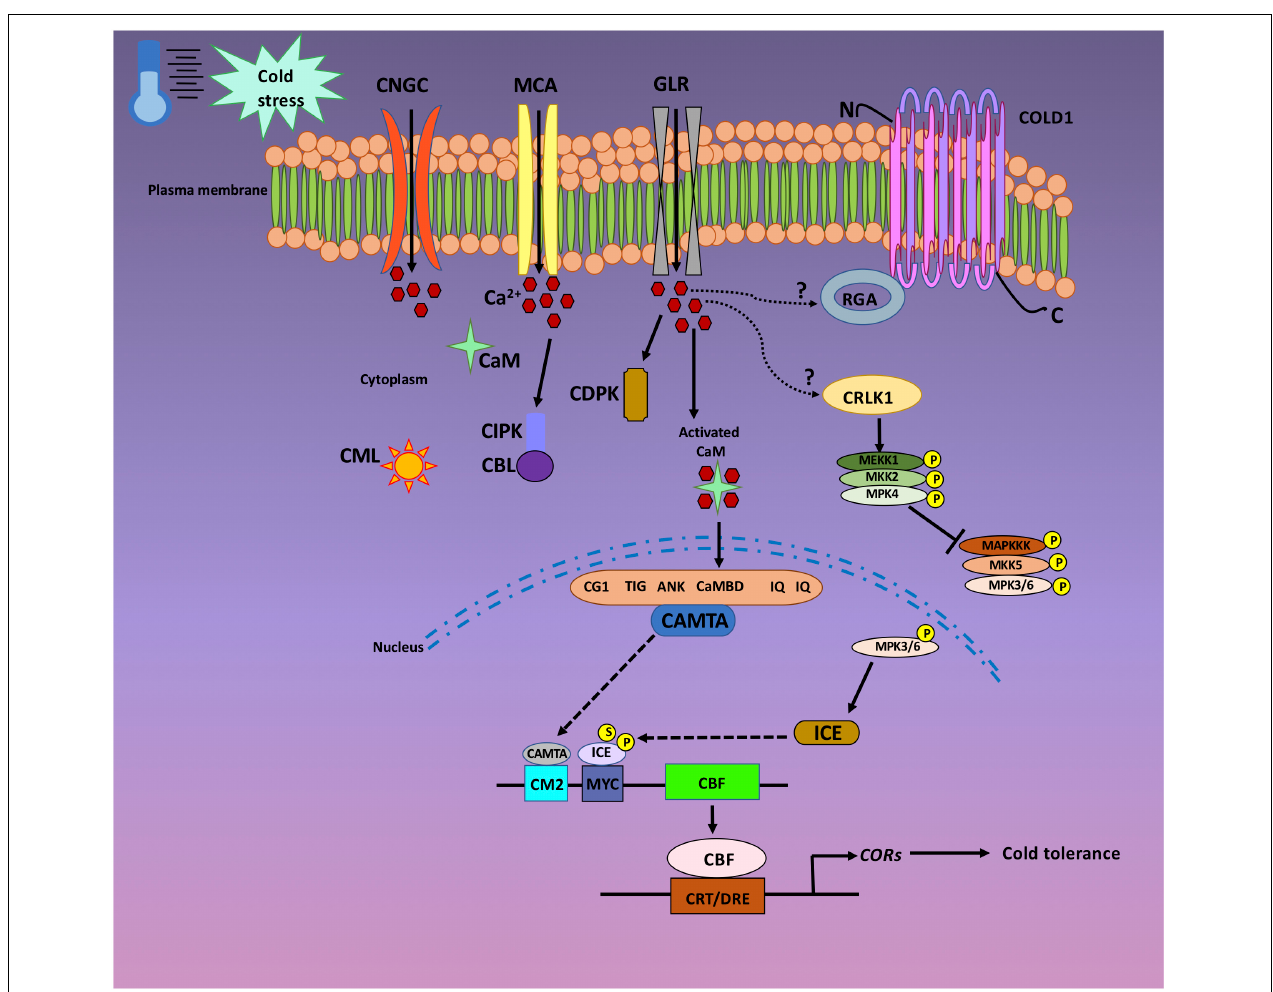
FIGURE 1 | Cold stress signaling in a plant cell. The plasma membrane is considered as one of the primary target for cold sensing and eventual transmission of Ca 2 + signals into the plant cell nuclei. Cyclic nucleotide-gated channels (CNGCs), glutamate receptor-like channels (GLRs), and the MID1-complementing activity (MCA) channels are the main plasma membrane Ca 2 + channels that allow the entry of Ca 2 + ions into the cytoplasm. Once the Ca 2 + ion enters the plant cell, they are sensed by Calmodulins (CaMs) and Calmodulin-like proteins (CMLs), Calcineurin B-like proteins (CBLs), and Ca 2 + -dependent protein kinases (CDPKs). Upon cold exposure, plasma membrane associated cold sensor chilling-tolerance divergence 1 (COLD1) interacts with G protein a subunit (RGA). Ca 2 + /CaM regulated receptor-like kinase (CRLK) positively regulate cold triggered gene expression by inducing the MEKK1–MKK2–MPK4 pathway. CRLK suppress cold-induced activation of MPK3/6 and is necessary for inducer of CBF expression (ICE) accumulation. ICE proteins are stabilized by either phosphorylation (P) or sumolyation (S). Calmodulin binding transcription activators (CAMTAs) activate C-repeat binding factor (CBF) expression through the CM2 (CCGCGT) promoter motif. CBF proteins eventually activate the expression of various cold-responsive (COR) genes which confers cold tolerance in